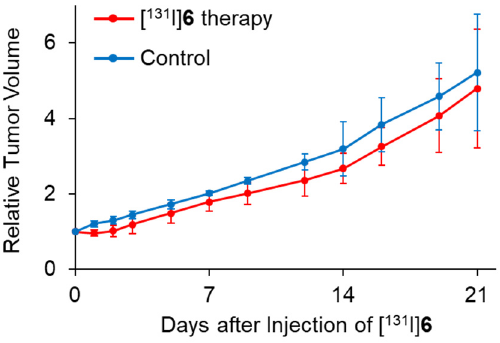
Figure 5. Curves depicting inhibition of growth of U-87 MG on therapy with [ 131 I] 6 compared with no treatment. Data are expressed as tumor volume relative to that on day of treatment (mean ± SD).